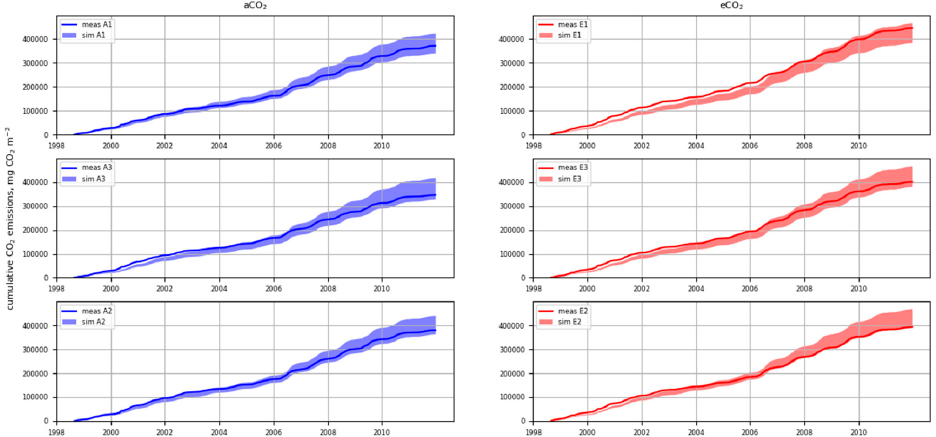
Figure 3. Cumulative measured and simulated CO 2 emissions from ambient (aCO 2 ) and elevated CO 2 (eCO 2 ) FACE rings. Plots are arranged according to increasing soil moisture from driest (top, A1 / E1) to medium (middle, A3 / E3) and wettest (bottom, A2 / E2) rings. Measurements are depicted in lines, and confidence intervals of simulations are depicted as colored